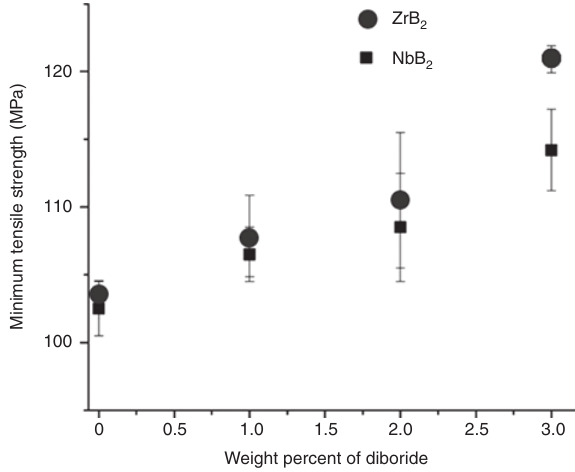
Figure 6 Measured MTS of aluminum wire samples as a function of the amount of diboride